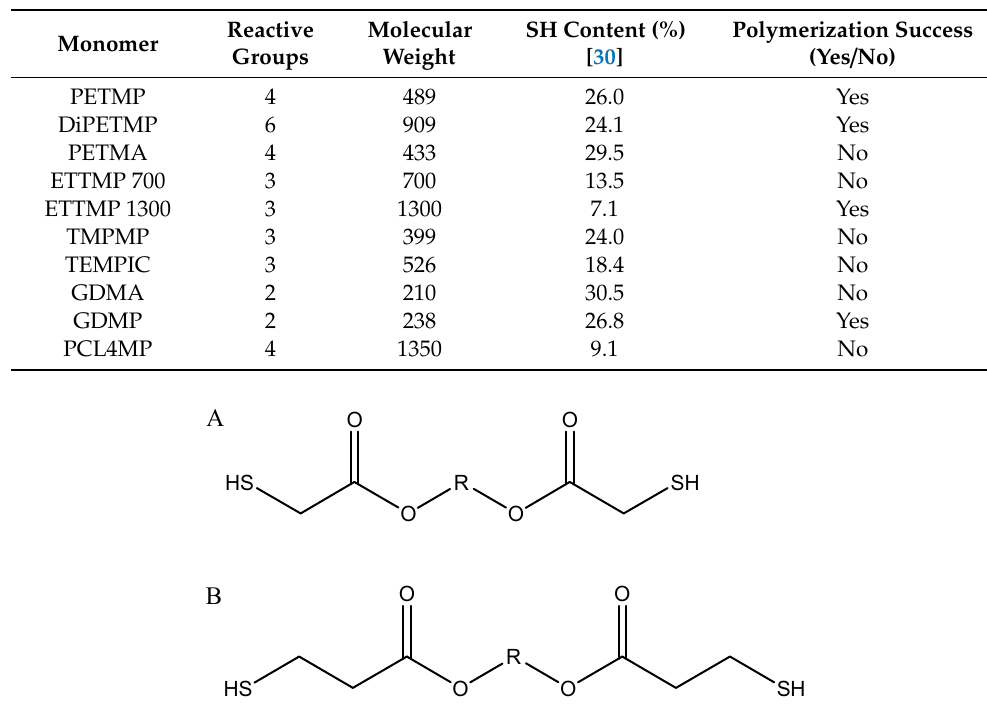
Figure 2. ( A ) Mercaptoacetate structure, and ( B ) Mercaptopropionate structure